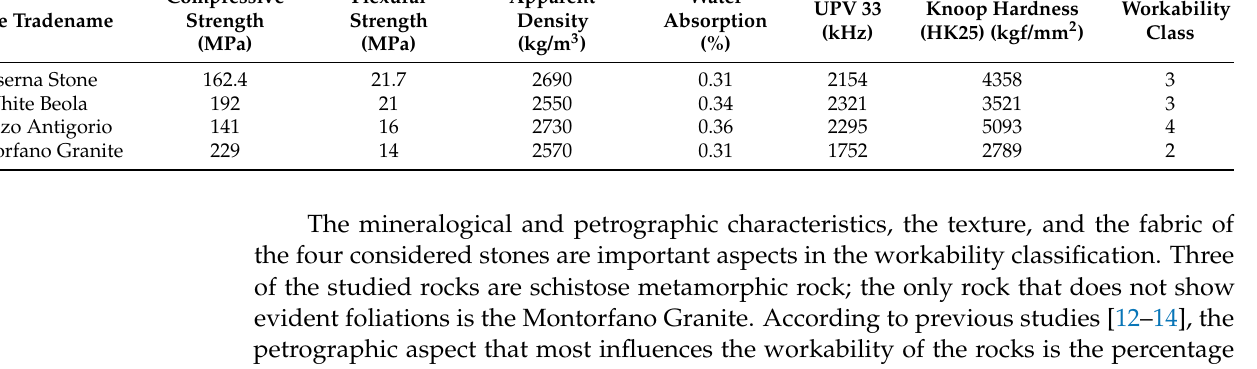
Table 4. Mechanical characteristics of the rocks tested. The values indicated are average of the values obtained for each sample. Stone Tradename